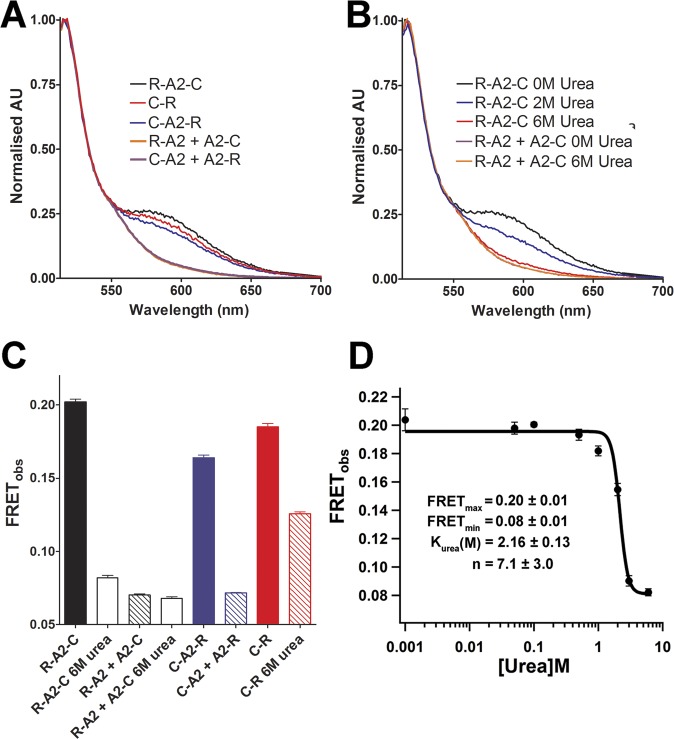
FRET efficiency of VWF A2 FRET proteins.(A) Normalised emission spectra at Ex505 for R-A2-C, C-R, C-A2-R, R-A2+A2-C and C-A2+A2-R. (B) Normalised emission spectra at Ex505 for R-A2-C and R-A2+A2-C in 0 and 6M urea concentrations. The normalised spectra for R-A2+A2-C (0 and 6M urea) and C-A2+A2-R overlay. Spectra are representative of three separate scans. (C) FRETobs values were determined for each variant(s) using the equation FRETobs = Ex505Em585/ (Ex505Em585+ Ex505Em516). (D) FRETobs values for urea titration against R-A2-C (VWF A2 FRET). The curve was fitted using the Hill titration equation. The fitted curve allows for calculation of the urea concentration at the mid-point of unfolding (Kurea), the cooperativity of unfolding (Hill coefficent, n) and the maximum and minimum FRETobs values of the fitted curve. Results are the mean±SD of at least 3 separate scans.